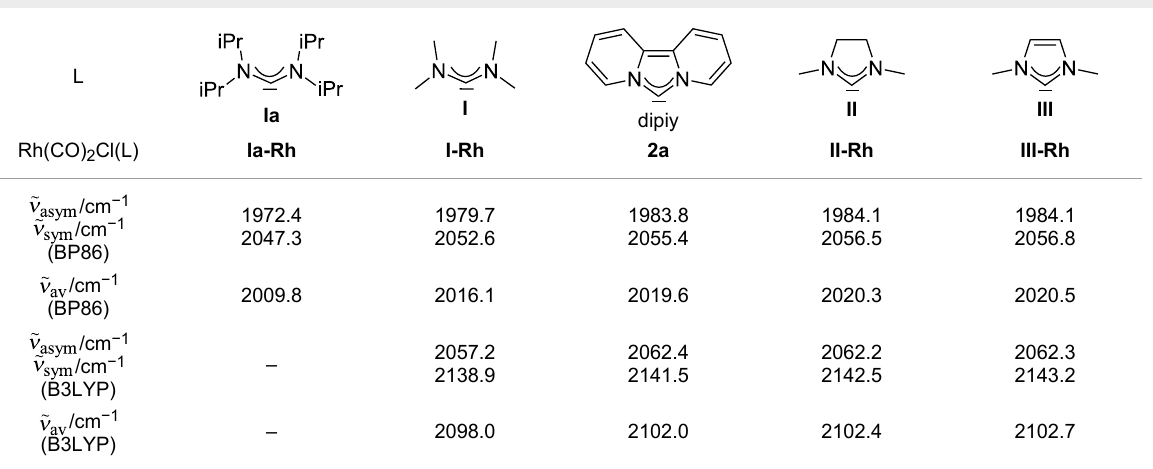
Table 2: Calculated values for the symmetric and asymmetric CO stretching frequencies as well as the